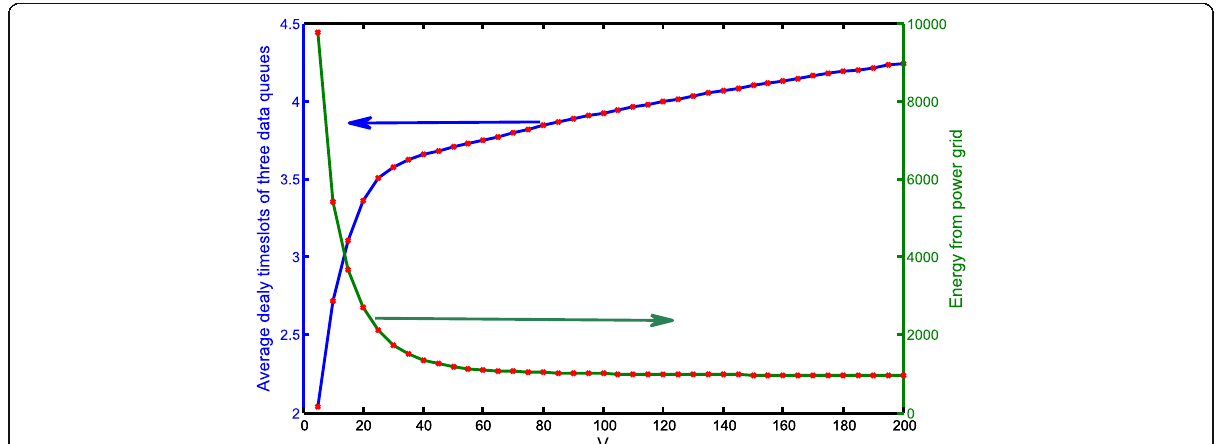
Fig. 7 Energy from power grid and average delay for different V values using our proposed